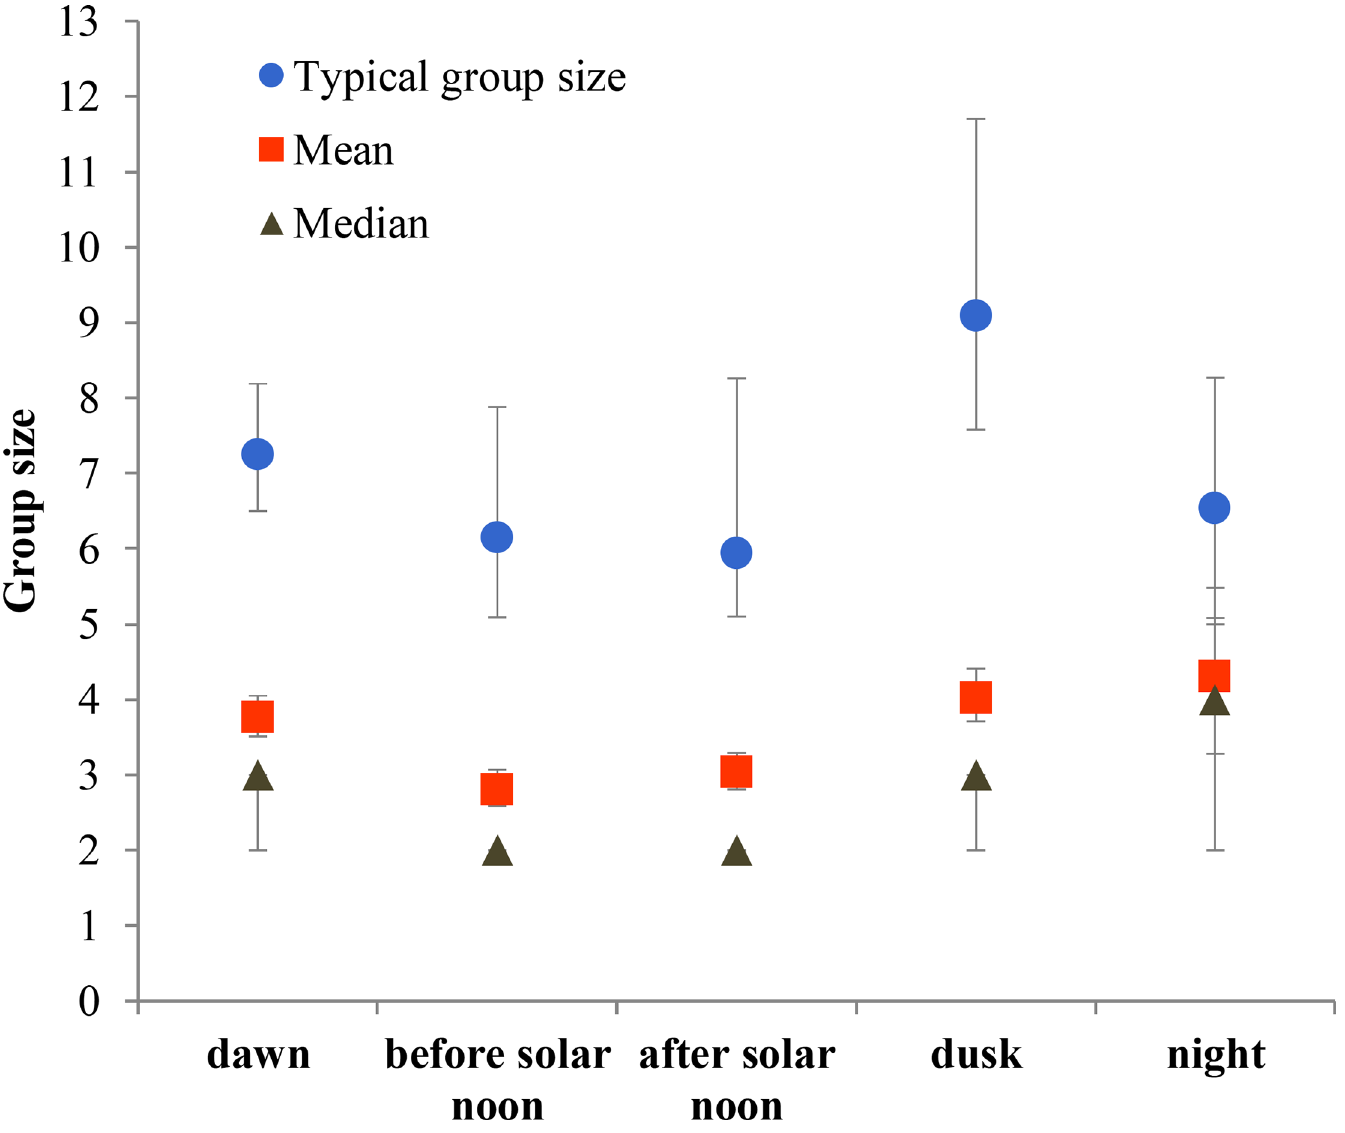
Fig 3. Typical, mean and median group sizes according to time of day. In typical and mean group sizes bars are 95% confidence intervals (CIs); in median group size CIs range between 95% and 96.2%. See S1 Table for detail